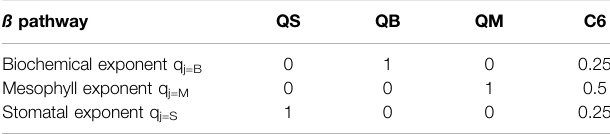
TABLE 2 | the con fi guration of the β i functions enabling the four sensitivity experiments with JULES. ß pathway QS QB